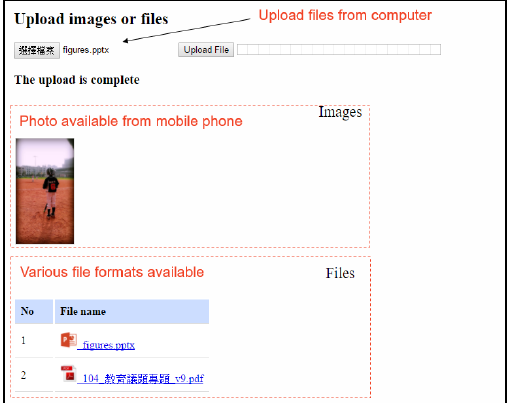
Figure 3. Concept node editing